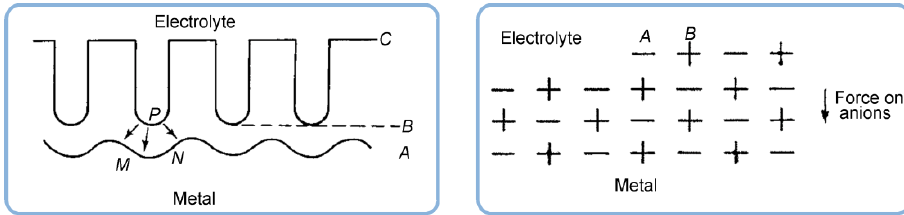
Figure 18. The mechanism for PAA formation in an acid bath proposed by Hoar and Mott. Left: the arrows PM and PN demonstrate the suggested paths of oxygen-containing species through PAA, Al 3+ ions move from MN toward P , where they can neutralize O 2− and be transferred into the solution, OH − move from P toward MN where they neutralize Al 3+ formed from the metal. Right: a schematic representation of PAA as a crystalline material in contact with the electrolyte solution. Reproduced with permission from [126]. Copyright 1959 Elsevier (Pergamon Press).